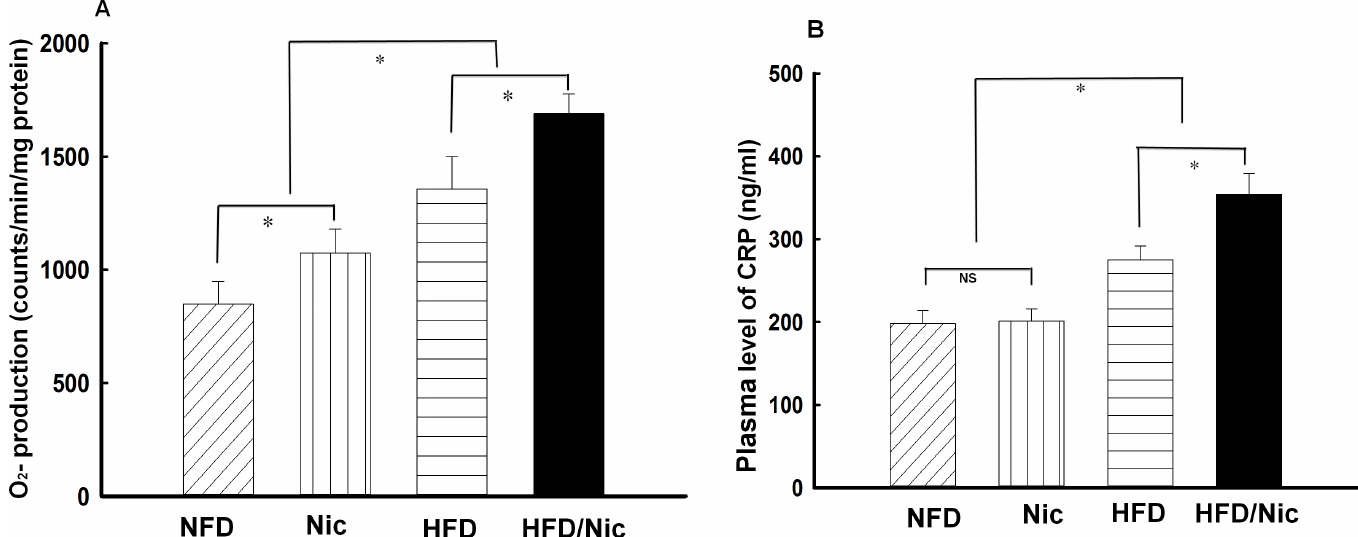
Fig 3. Aortic superoxide (O 2- ) production (A) and plasma level of C-reactiveprotein (CRP, B) in nicotine-treated obese rats. HFD for 20 weeks increasedaortic O 2- productionand plasma level of CRP. NicotineincreasedO 2- productionin both lean and obese rats, and increasedplasma level of CRP only in HFD rats. * p < 0.05,vs. NFD, #p < 0.05vs. HFD, N = 6–7.